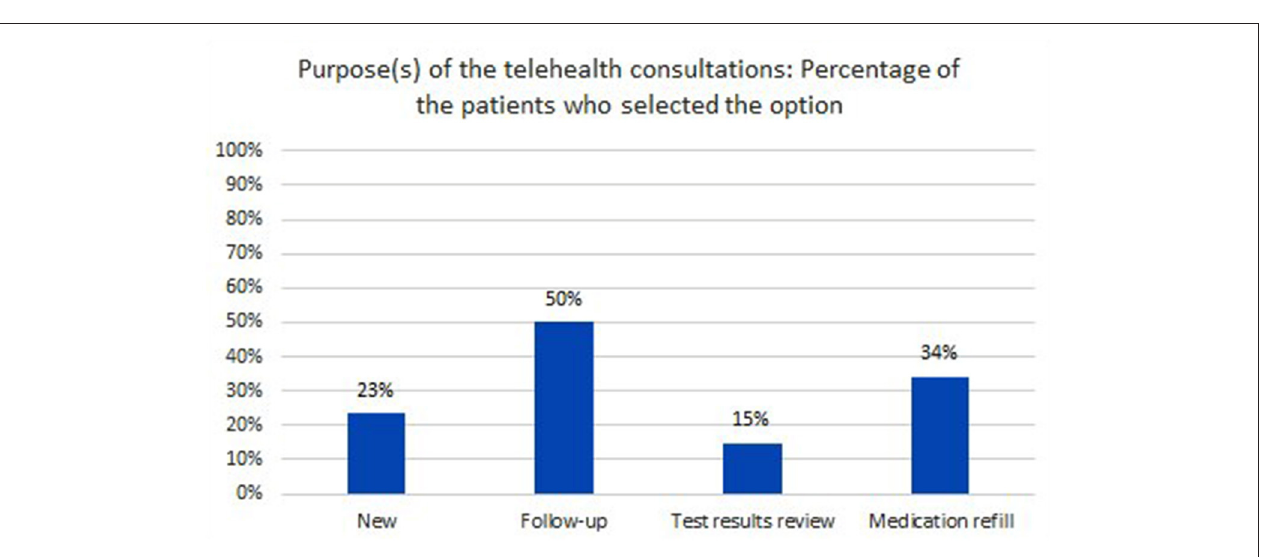
FIGURE 6 | Distribution of patients, based on purpose(s) for